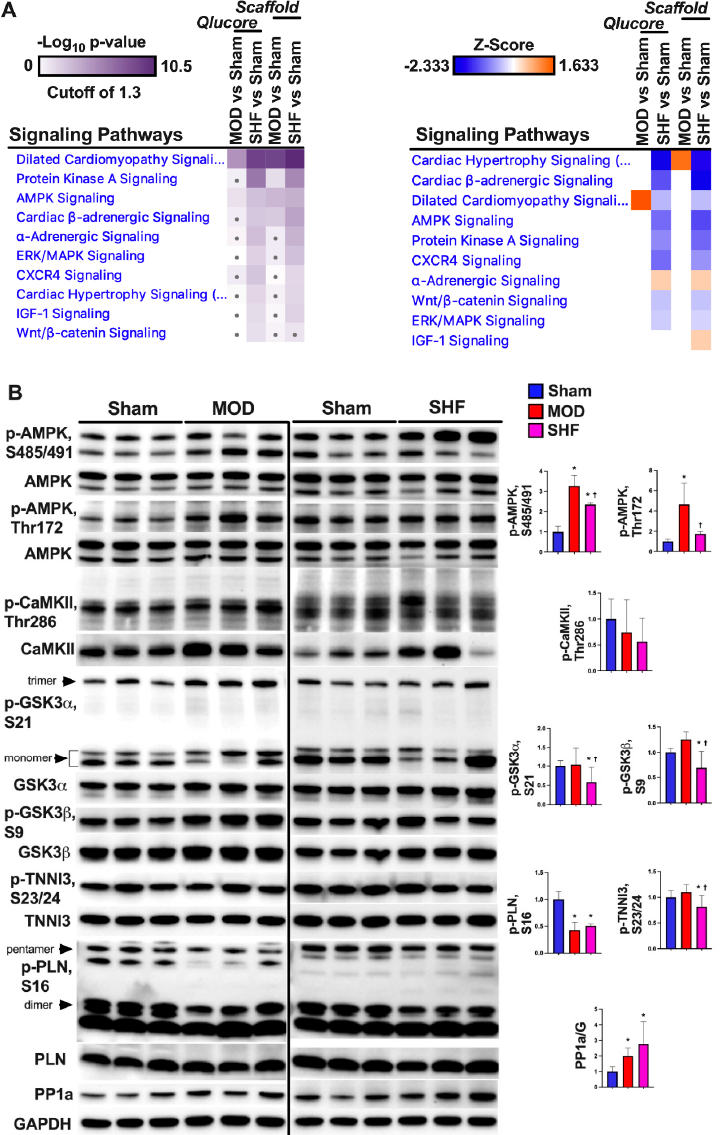
Figure 7. Top-ranked Signaling Pathways in the MOD and SHF groups. ( A ) ‘Core Analyses’ of the statistically analyzed p-proteomic datasets by Qlucore and Scaffold bioinformatics software was